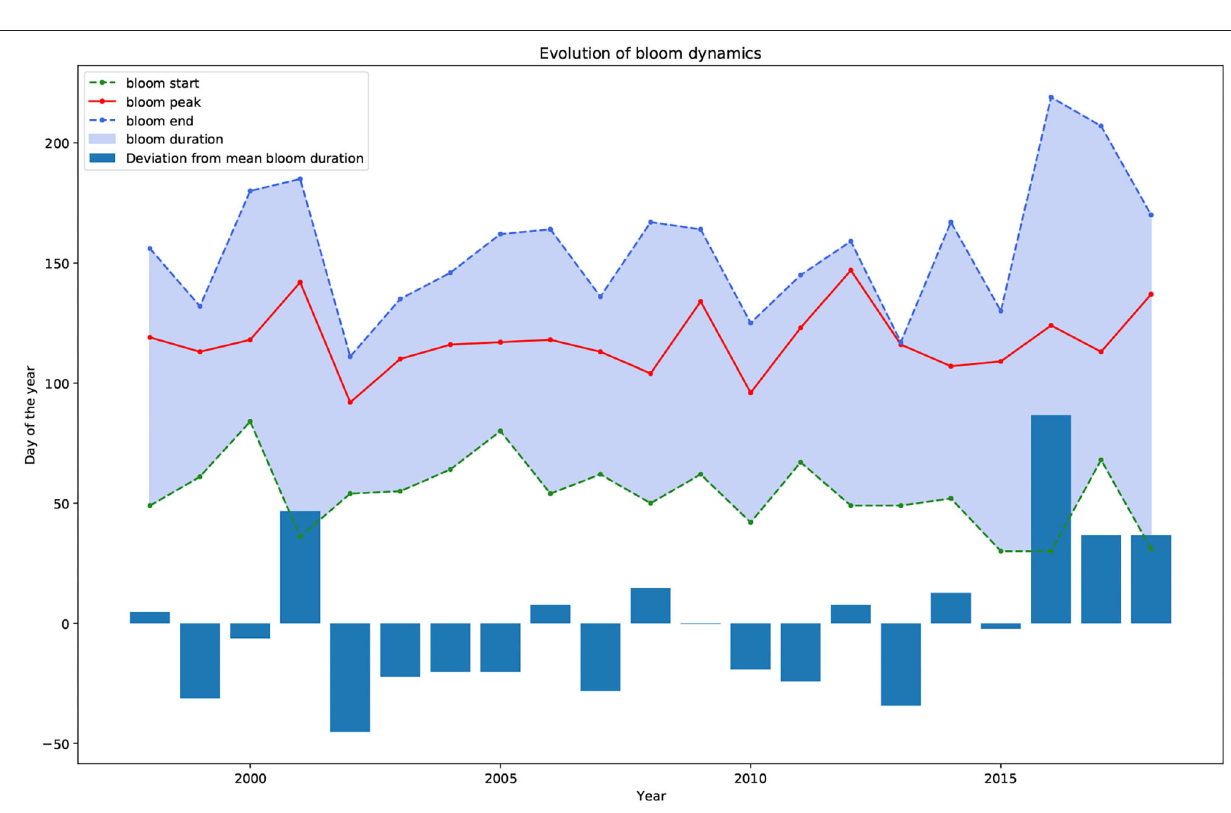
very much debated (Xu et al., 2020). In fact, some studies